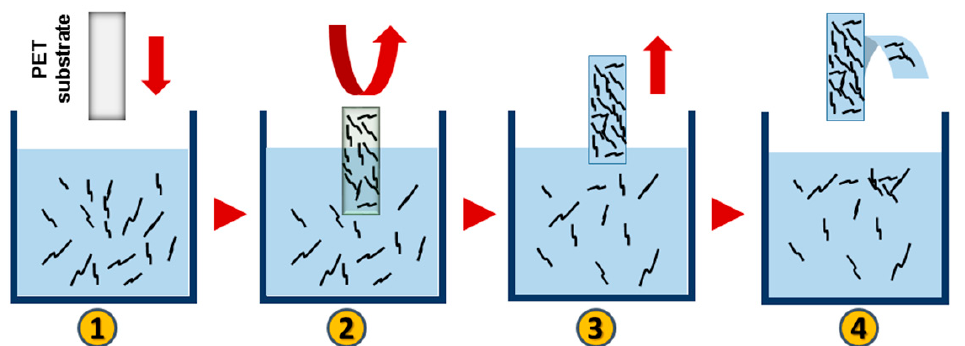
Figure 3. Stages of forming of the electrically conductive layer on the PET substrate by dip-coating: (1) immersion of the PET substrate in the MWCNT/EOC dispersion, (2) incubation for 10 s, (3) withdrawal (wet layer formation), (4) draining, solvent evaporation for 24 h, and peeling off of the tape with the composite layer from one side of the PET substrate.